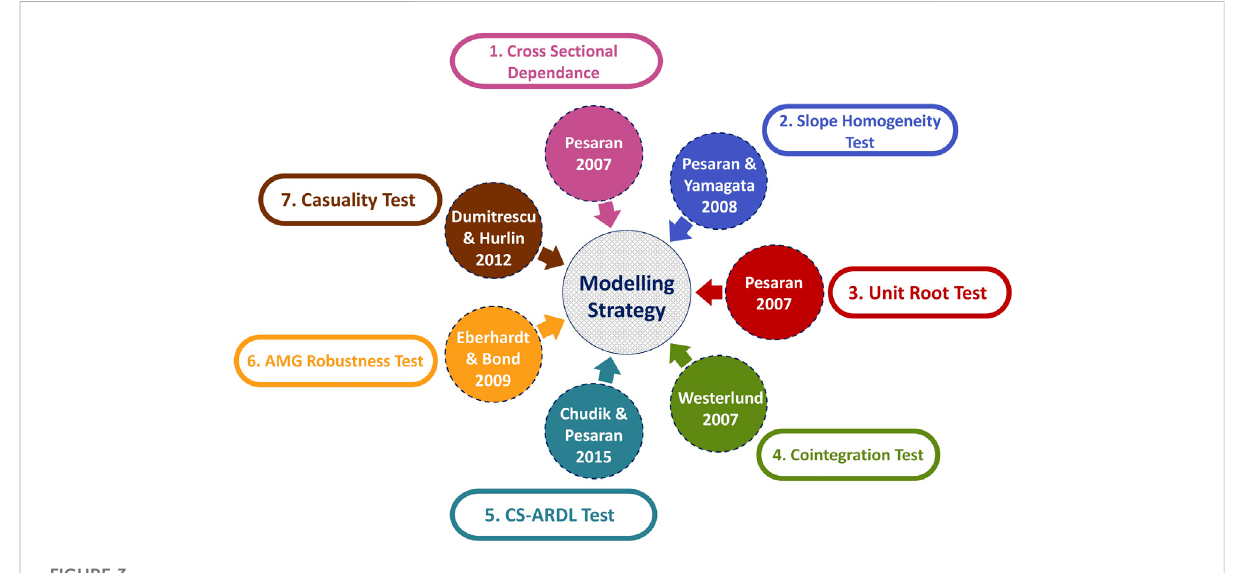
FIGURE 3 Econometric modelling